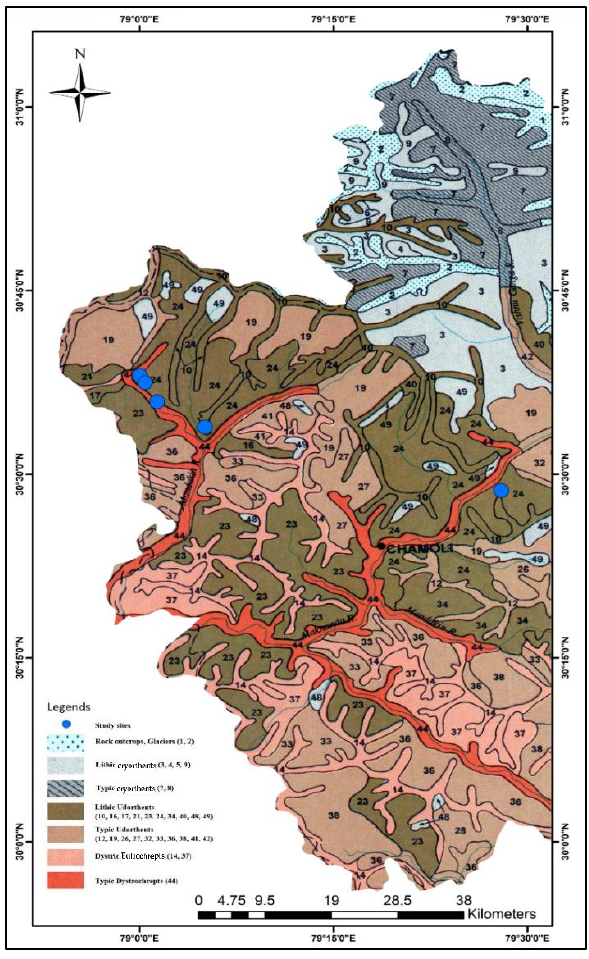
Figure 4. Soil map of the study area showing that the selected landslide sites and the reference site (blue circle) have a similar soil type, i.e., Lithic Udorthents (Entisols) (NBSS&LUP,